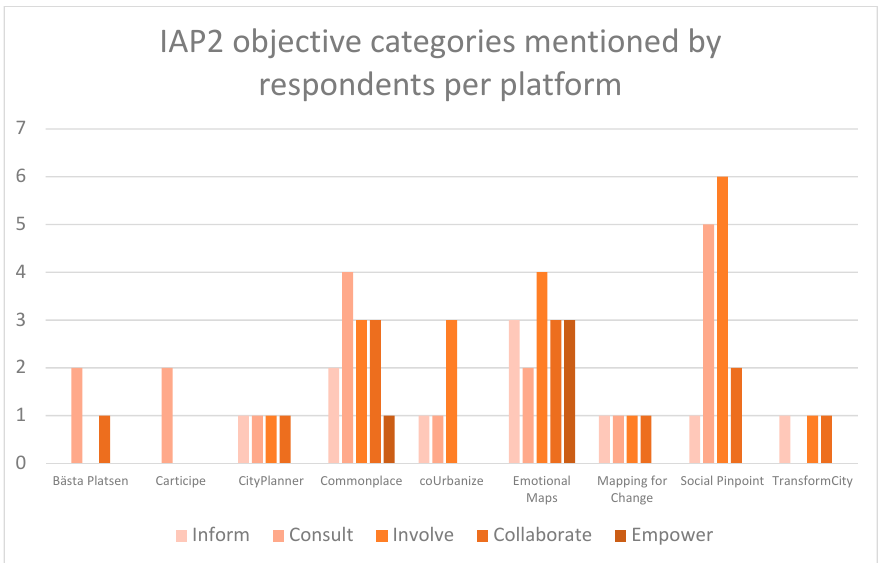
Figure 3. The division of IAP2 objective categories mentioned in our survey by respondents using various platforms.